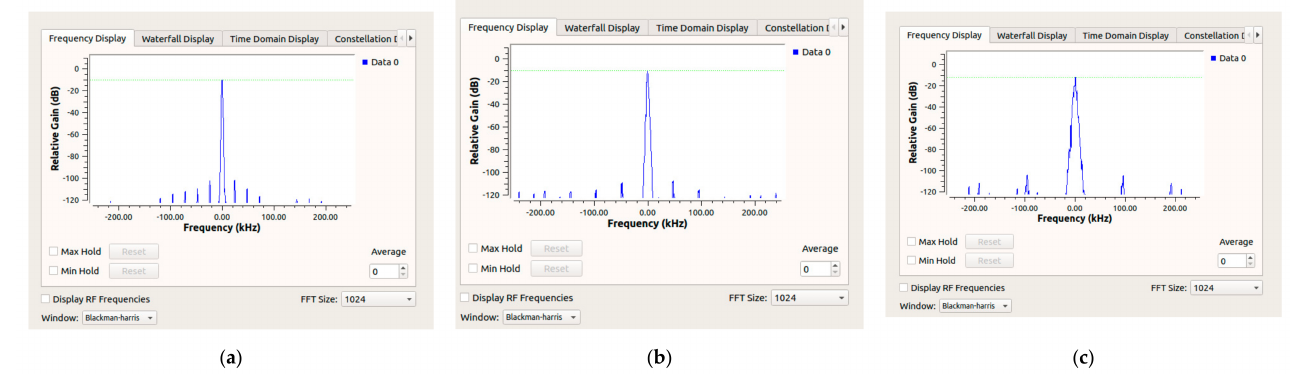
Figure 11. ( a – c ) The transmitted signals of 2400 bps, 4800 bps and 9600 bps, respectively. No noise added.